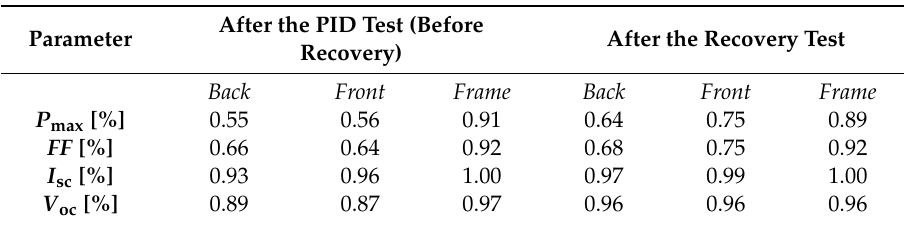
Table 1. Normalized electrical parameters to pre-PID test value of modules, before and after the recovery